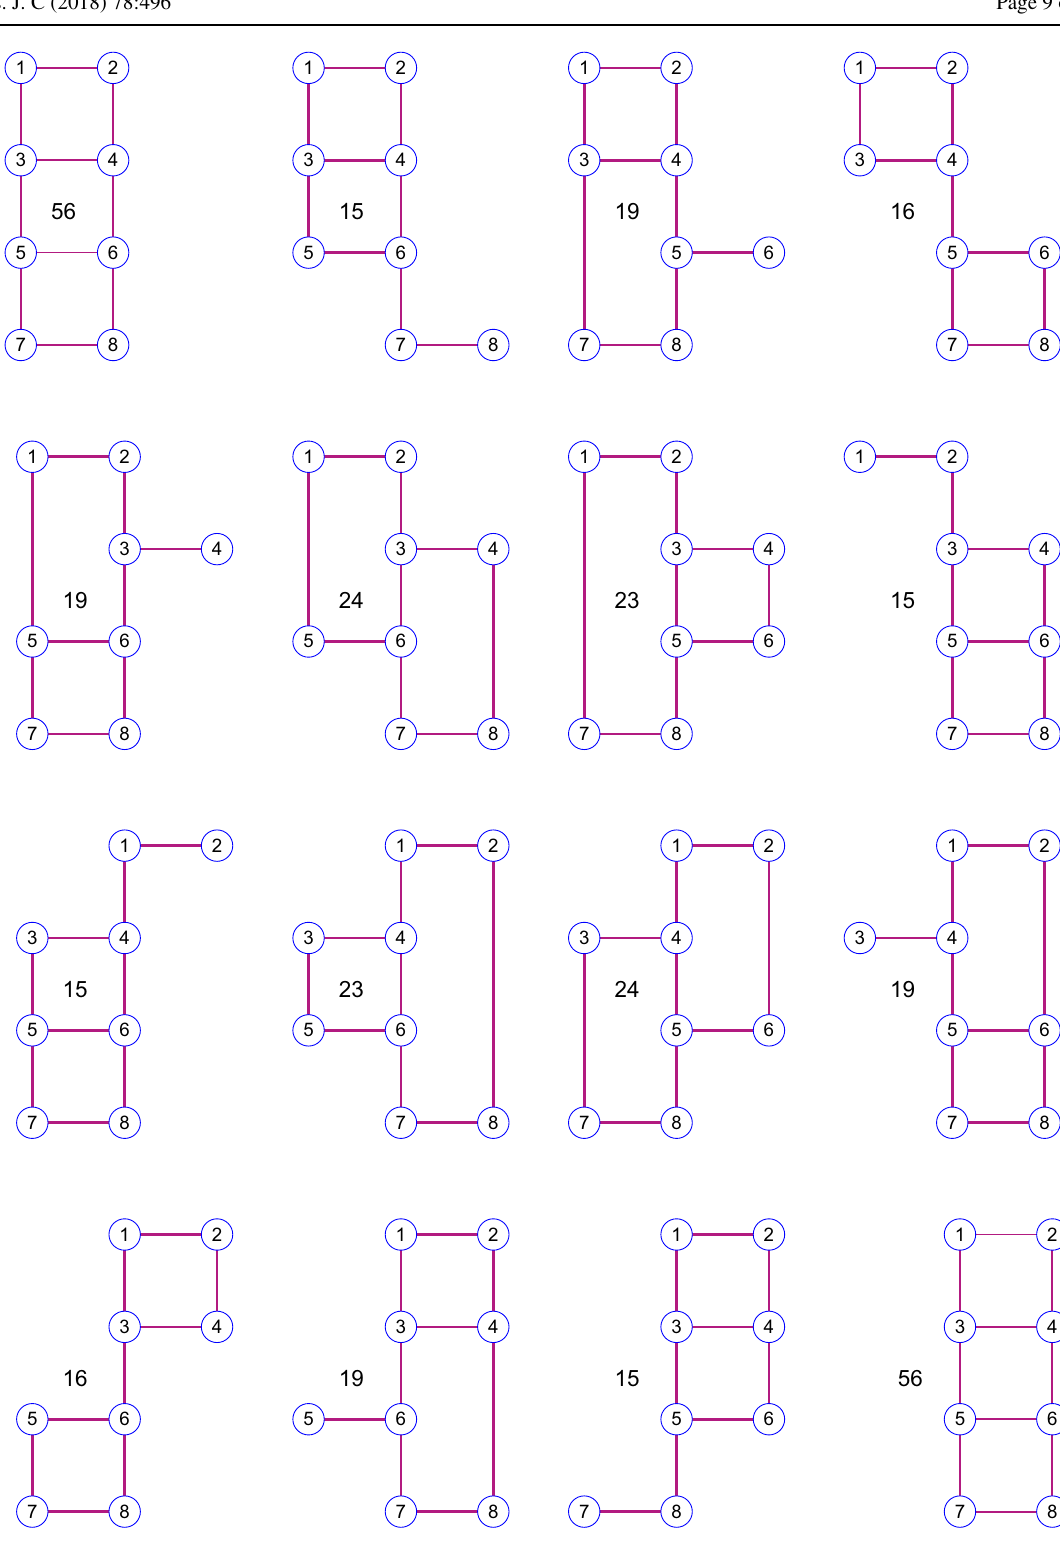
R, R, L}, {L, R, R, R}, {R, L, L, L}, {R, L, L, R}, {R, L, R, L}, {R, L, R, R}, {R, R, L, L}, {R, R, L, R}, {R, R, R, L}, {R, R, R, R}. The corresponding complexity for each graph is